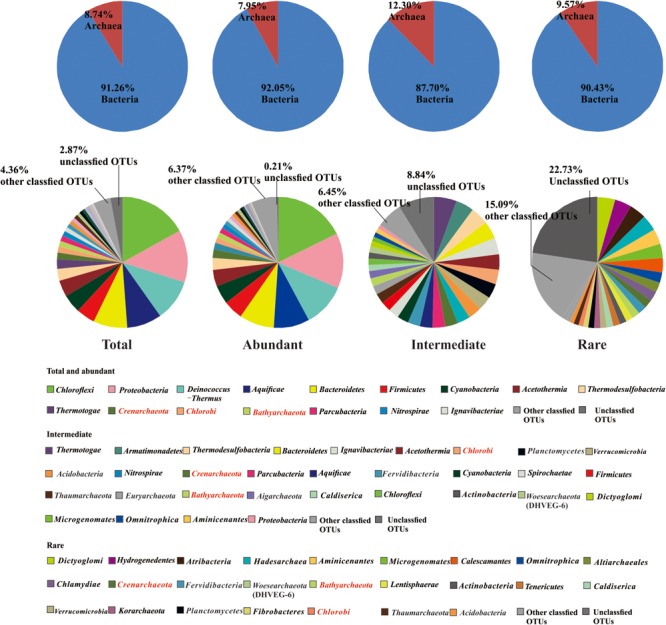
Relative abundance of bacteria and archaea (the upper row), and microbial community composition (at the phylum level) of the total, abundant, intermediate, and rare biospheres (the lower row) (in the caption, characters in red indicated the phyla occurring among the abundant, intermediate, and rare biospheres).